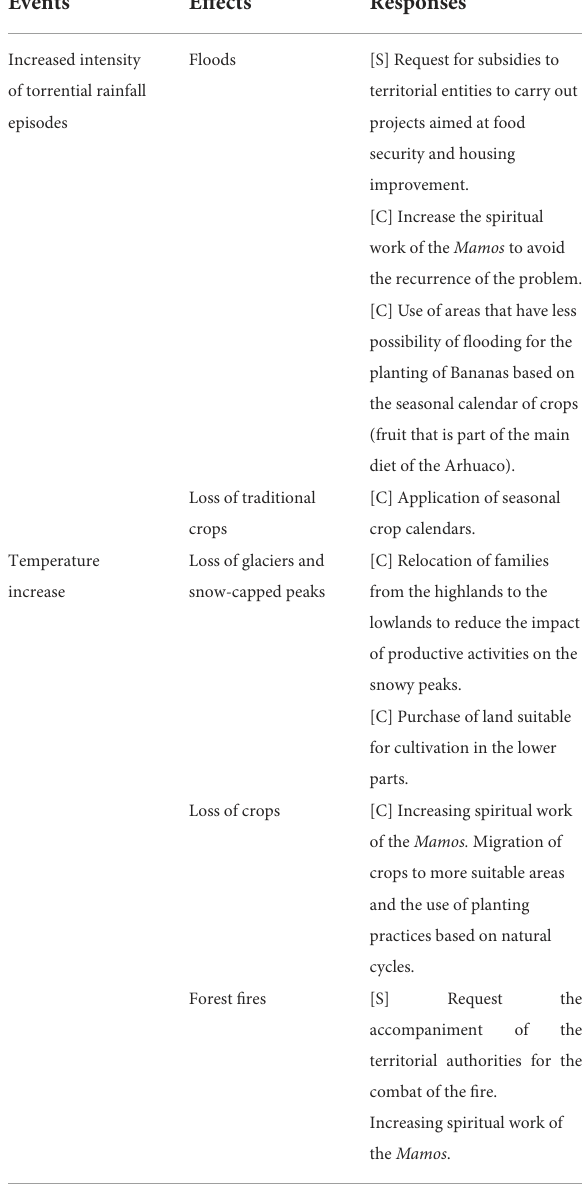
TABLE 3 Responses to effects of climatic variability-related